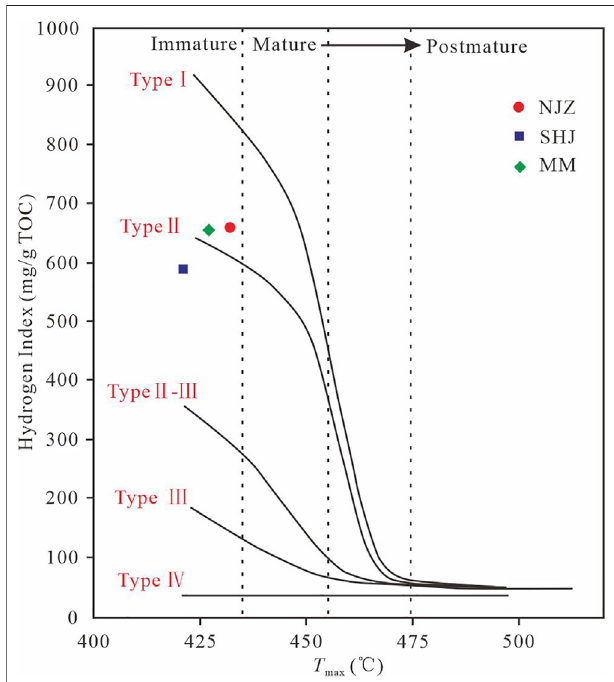
FIGURE 1 | Hydrogen index (HI) plotted versus T max values modi fi ed from Shalaby et al. (2011).